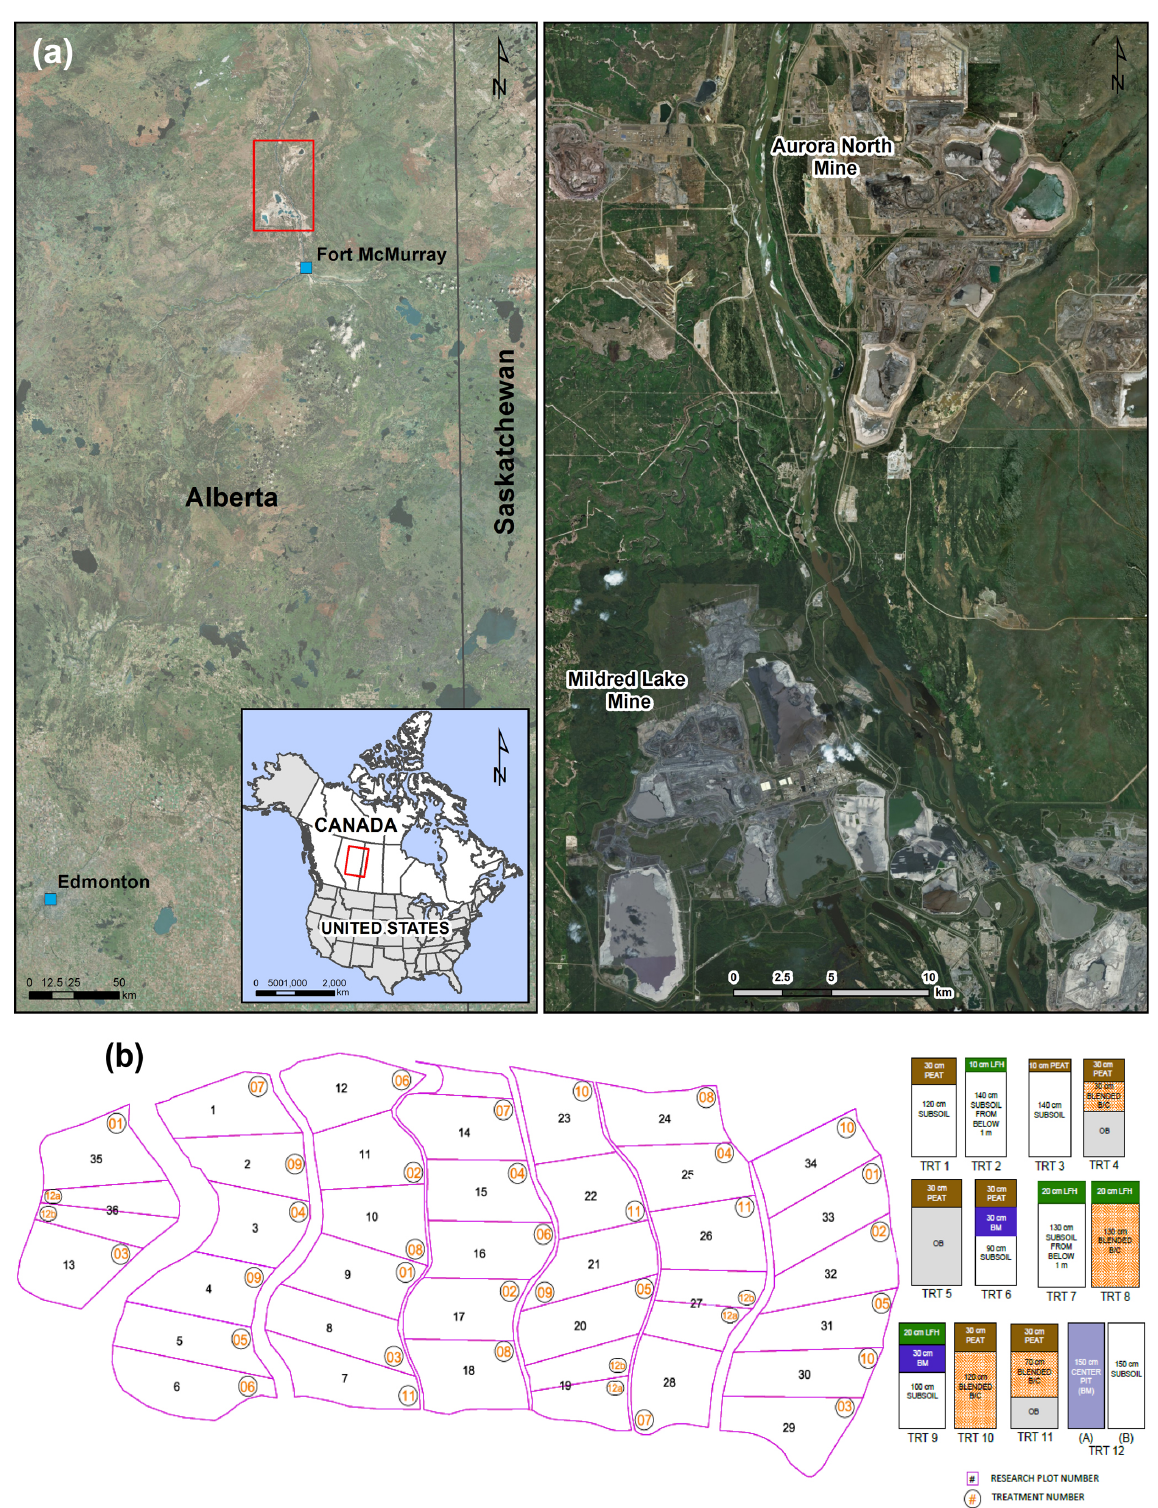
Figure 1. (a) Location map of Aurora North Mine of Syncrude Canada Ltd. (map sources: Esri, DigitalGlobe, GeoEye, Earthstar, Geo- graphics, CNES/Airbus DS, USDA, USGS, Aerogrid, IGN, and the GIS User Community) and (b) soil cover design treatments (TRT) at ASCS (adapted from OKC, 2017). LOS overburden (OB) underlies all treatments, even though treatments with less than 150cm total soil cap thickness only show